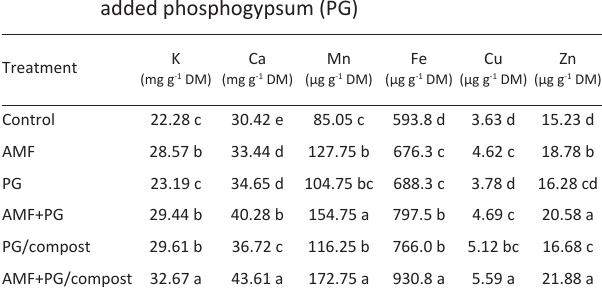
Mean values within columns followed by different letters are significantly different at